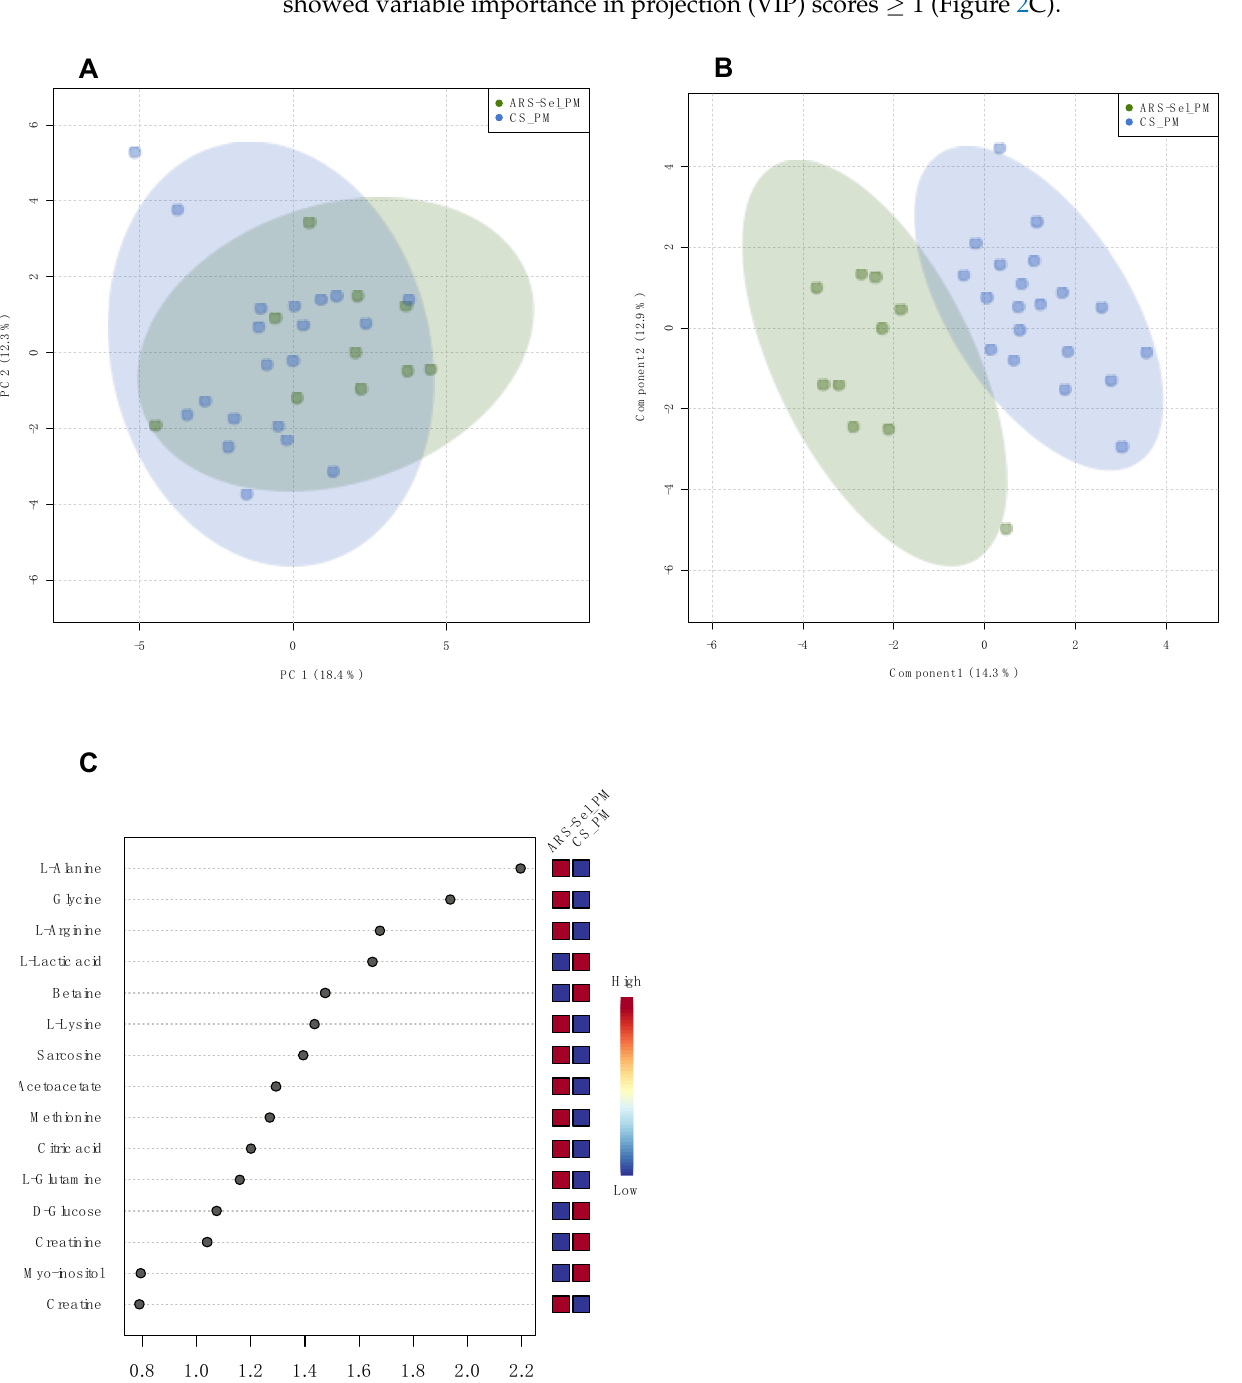
(plasma: Supplementary Figure S1B,D; digesta: Supplementary Figure S2B,D), meaning